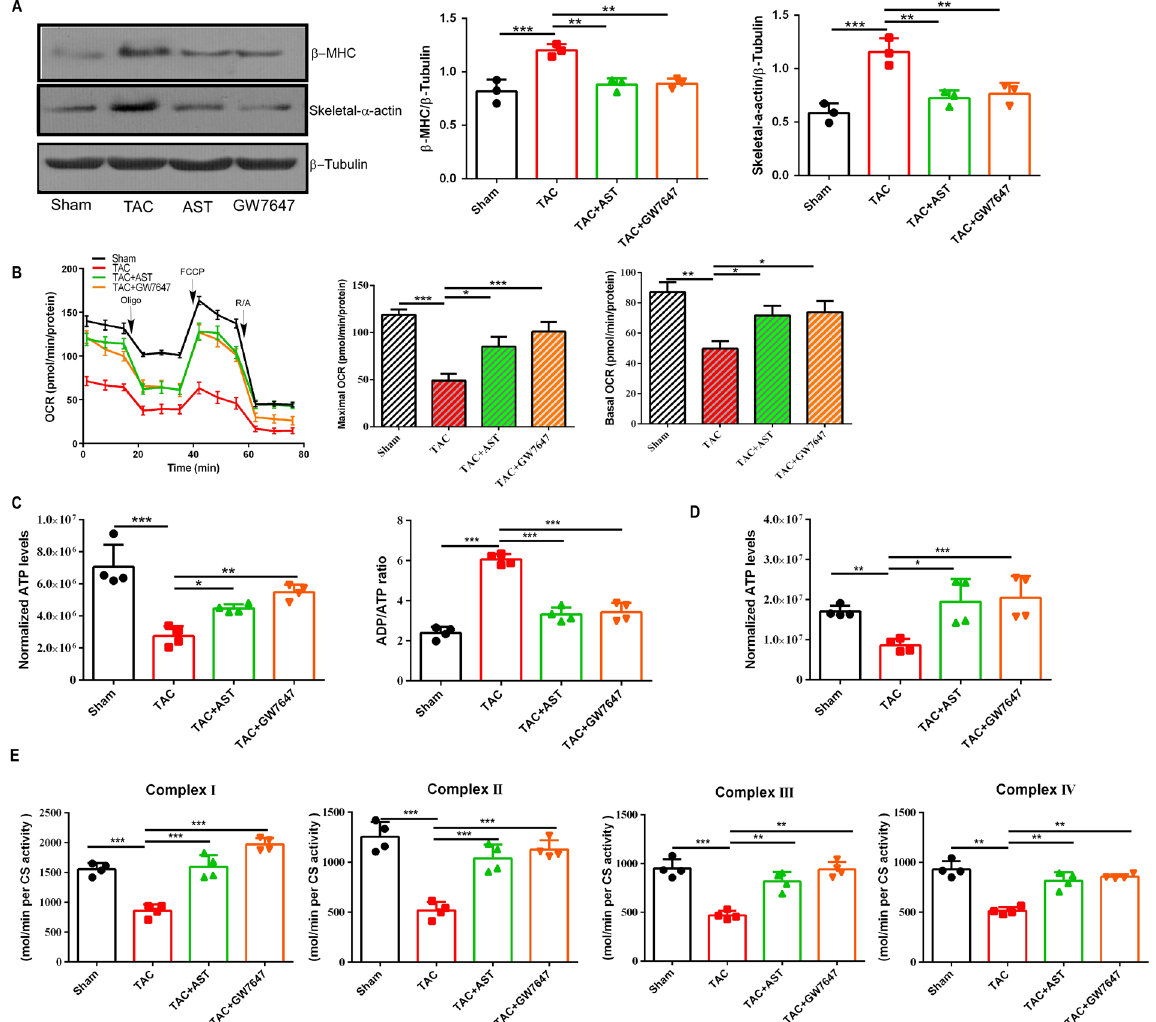
Figure 3. The effect of Astragaloside IV treatment on the mitochondrial respiration rate and the production of ATP in isolated hypertrophic myocardial cells. ( A ) Western blotting analysis of β -MHC and skeletal α -actin expression. The original gels images used for A are shown in Supplementary Fig. S2. ( B ) Oligomycine (0.5 μ M), carbonyl cyanide-4-(trifluoromethoxy)phenylhydrazone (FCCP) (1 μ M), rotenone and antimycin A (1 μ M) were injected sequentially at indicated time points into each well containing isolated myocardial cells. Mitochondrial function was assessed by the basal and maximal cellular oxygen consumption rates (OCRs). The representative time course data for the OCR and aggregated data are shown. ( C ) The ATP level expressed relative to control and the ADP/ATP ratio for each group (n = 4). * P < 0.05, ** P < 0.01 and *** P < 0.0001 (n = 5). Data are mean ± s.d. ( D ) The ATP level expressed relative to sham in vivo . * P < 0.05, ** P < 0.01 and *** P < 0.0001 (n = 3). ( E ) The activity of the ETC complexes I, II, III, and IV in cardiac mitochondria. Activities of ETC complexes normalized to mitochondrial protein(mg), respectively. Data are mean ±